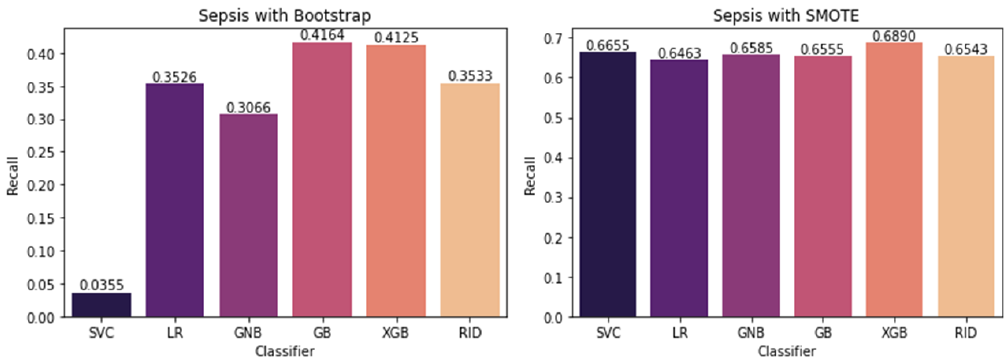
Figure 2. Comparison of various classifiers SVC: support vector machine, LR: logistic regression, GNB: Gaussian Naive Bayes, GB: gradient boosting, XGB: XGboost, and RID: ridge classifiers were used. Only the training set (80% of data) is used for data augmentation and model